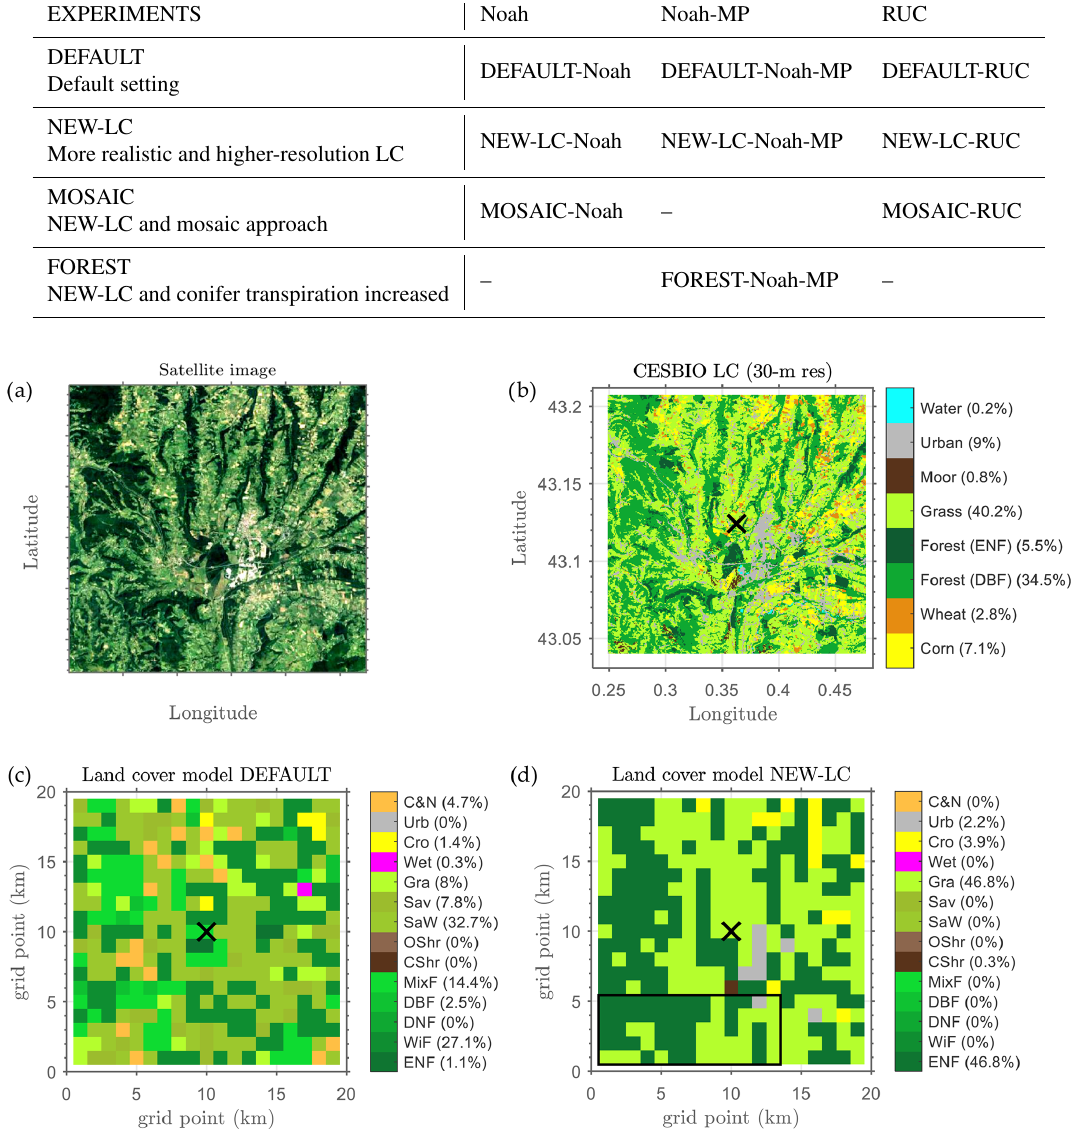
Figure 2. (a) Satellite picture of the area analysed (from © Google Earth, image Landsat/Copernicus). (b) CESBIO land cover map from 30m resolution data. (c) Dominant land cover (1km) used in the default experiment (DEFAULT) from the IGBP-MODIS database. (d) Dominant land cover (1km) used in NEW-LC experiment, obtained from the CESBIO land cover map shown in (b) . The black rectangle indicates the area with a soil type dominated by loam, which was not used for the evaluation. The rest of the area was characterized by clay loam (dominantly), as the pixels including the sites where the EC measurements were taken (maximum 4km away from the central point of the BLLAST field campaign, indicated with a black x symbol). The complete names corresponding to each LC category abbreviation are included in Appendix